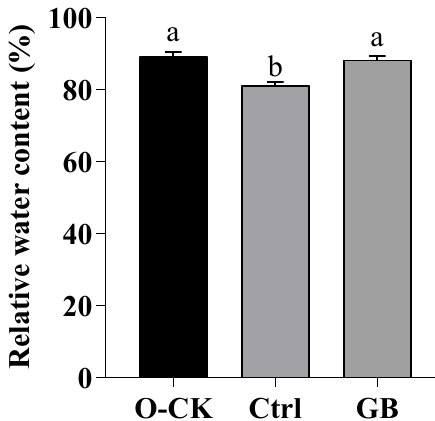
Figure 1. Effects of GB on relative water content (RWC) in B. rapa under heat stress. Data are shown as mean ± SD. Different lowercase letters indicate significant difference at p < 0.05. O-CK, optimum conditions, foliar sprayed with water; Ctrl, foliar sprayed with water before exposure to heat stress; GB, foliar sprayed with GB before exposure to heat stress.